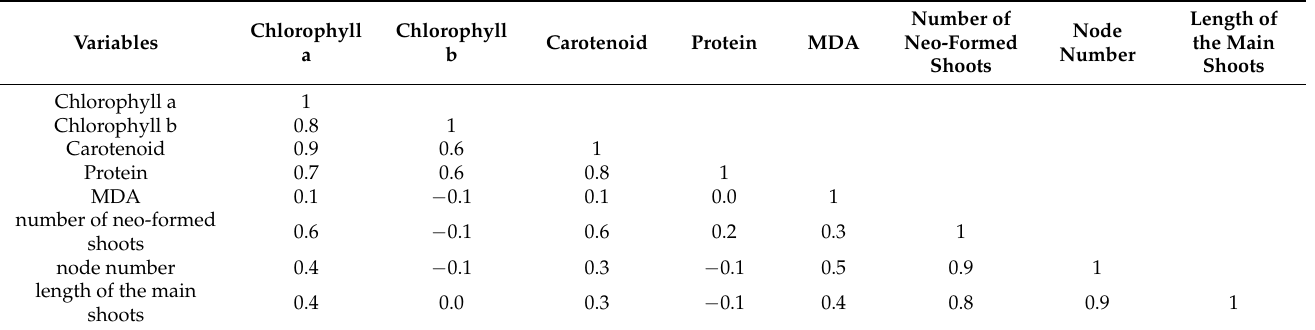
Table 5. Correlation matrix, Pearson’s coefficient, and significance ( p -value = 0.05).